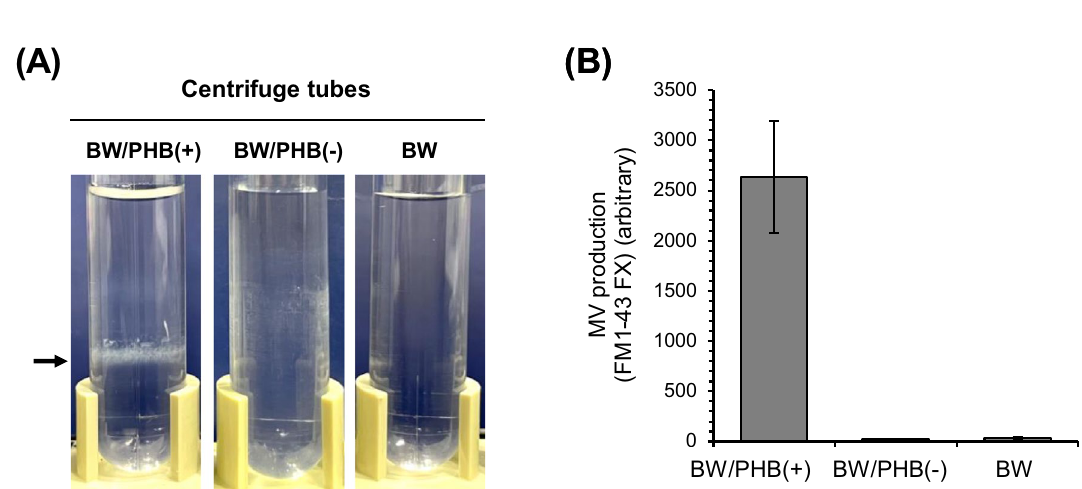
Figure 2. Comparison in the amount of the MV-fractions isolated from culture supernatant of BW/PHB (+), BW/PHB (−) and BW. ( A ) MV purified by density gradient-ultracentrifugation. The black arrow indicates MV fraction for BW/PHB (+). ( B ) Comparison of MV production. The data are shown as the mean ± standard deviation from three independent